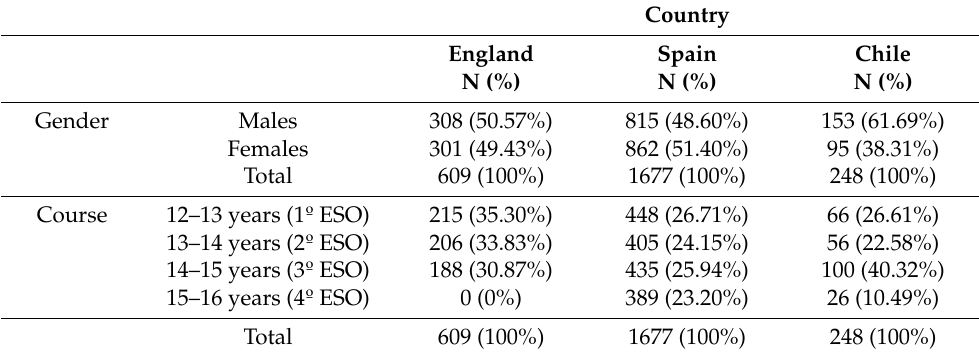
Table 1. Descriptive data of the sample.